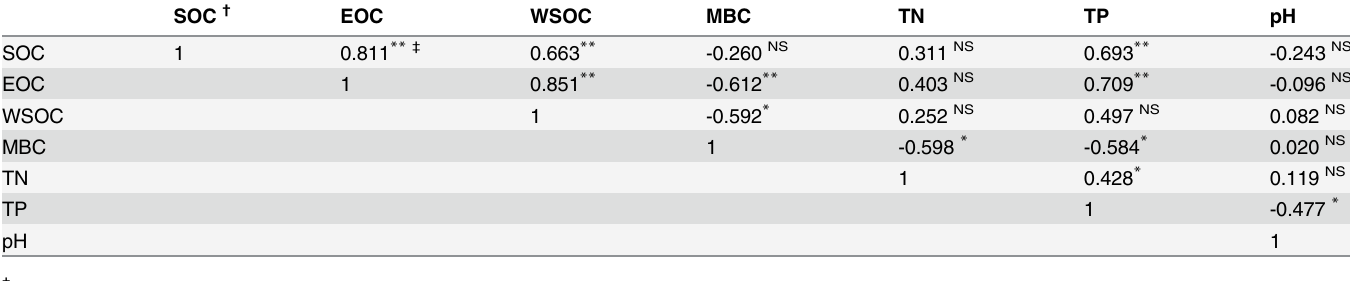
† see Table 1 for abbreviations. ‡ * P < 0.05